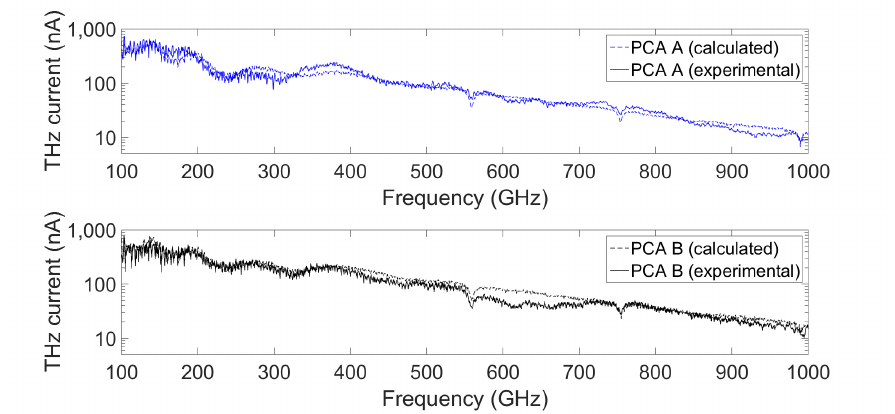
Figure A2. Comparison between the experimentally obtained and the calculated rectified current of PCA A and